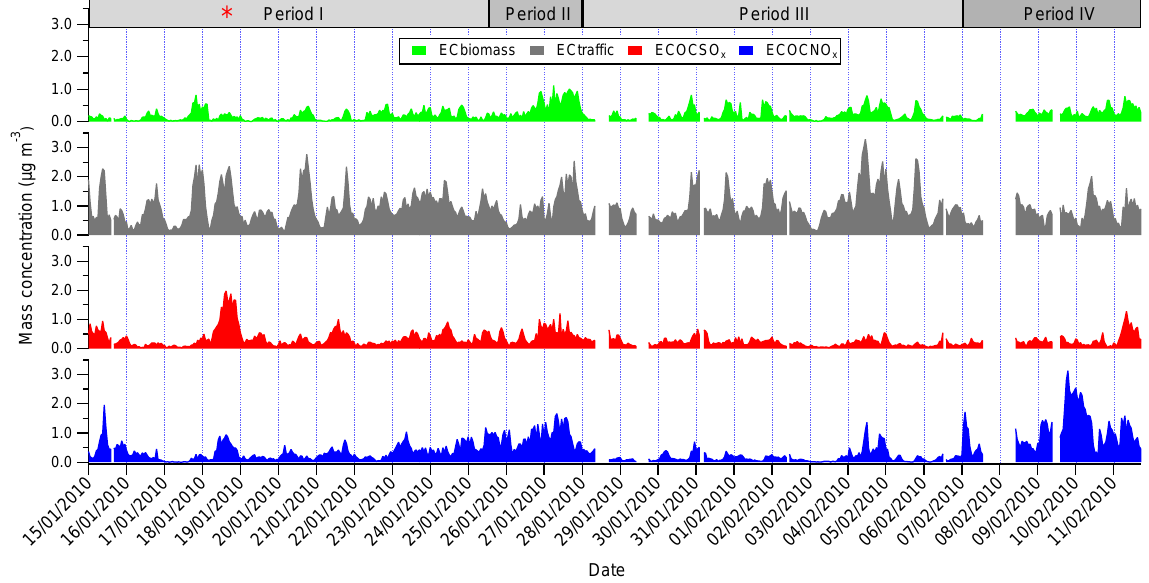
Fig. 4. Temporal trends of hourly scaled mass concentrations for the 4 ATOFMS EC classes. The measurement period is split into 4 parts as described in Sect. 3.2. The red asterisk denotes the fog